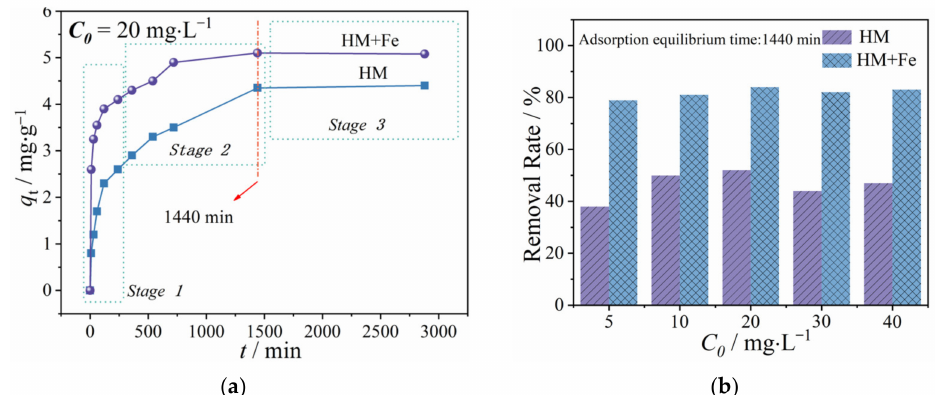
Figure 1. Effect of aging on the adsorption equilibrium and removal rate of TC by humic acid. ( a ) Effect of contact time on TC adsorption. ( b ) TC equilibrium removal rate under various initial concentrations.